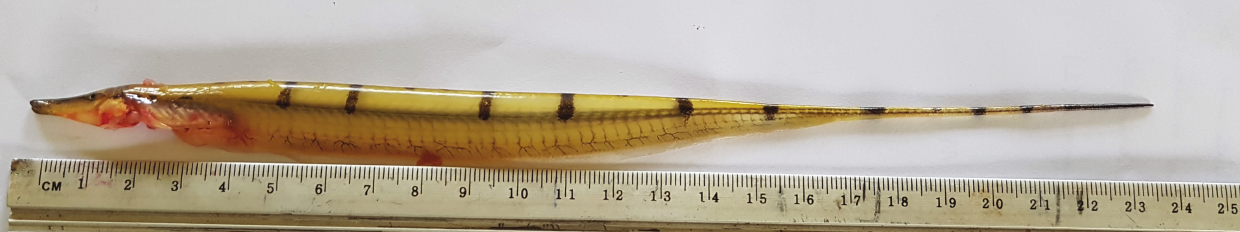
Fig. 2. Gymnorhamphichthys britskii sampled in the Dourado stream, Mato Grosso do Sul State,